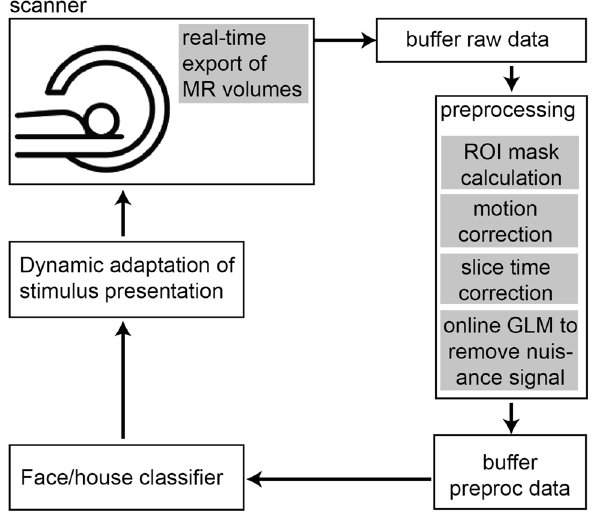
Figure 2. Technical set-up. The technical set-up used for real-time fMRI as used by Ref. 28 . The data was exported in real-time into a FieldTrip buffer, and then immediately preprocessed. A structurally defined ROI mask was calculated. The mask and preprocessed data were imported into BrainStream for online decoding analysis. See “Methods” for more